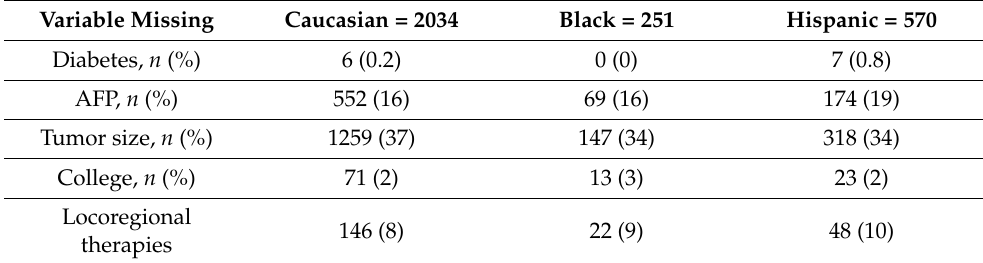
Table A1. Missing data stratified by